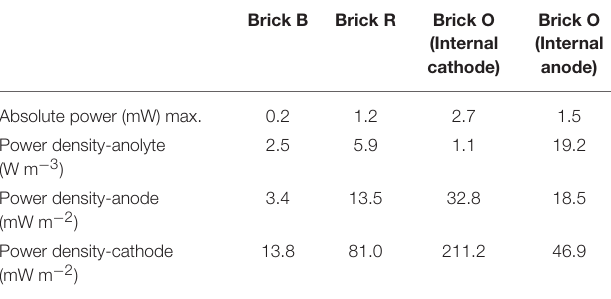
Brick O (Internal cathode) anode)